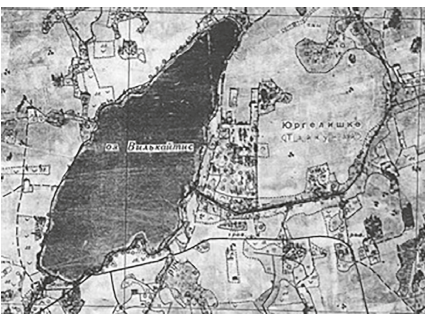
Figure 1: Fragment of the contour photo plan N-34-72-G-b-1 of 1953 made on the basis of the flight of 1946 (source: the Lithuanian State Land Fund